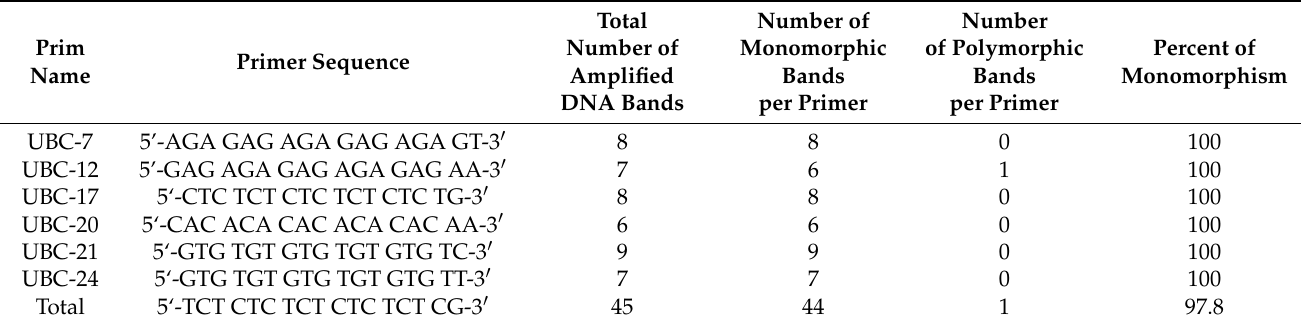
Table 3. List of primers and their sequences of the amplified fragments generated by ISSR markers for DNA fingerprinting of in vitro M. oblongifolia plants under ZnO NPs exposure.